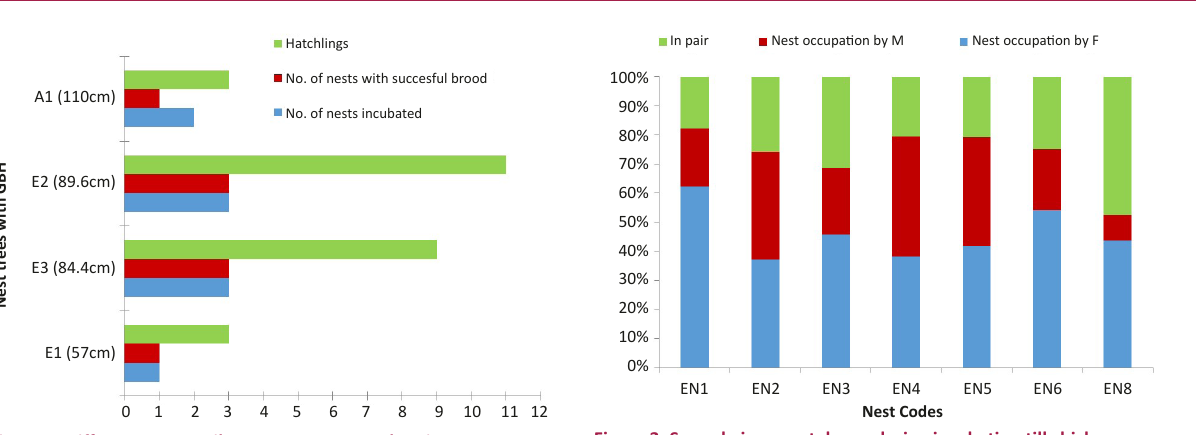
Figure 2. Different nest attributes on nest trees showing GBH